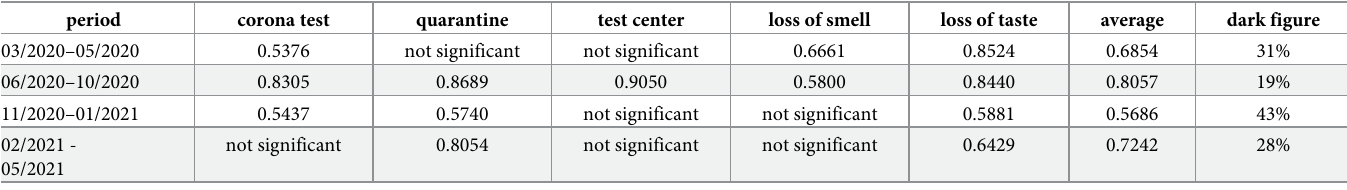
Table 4. Correlation in different sections of the